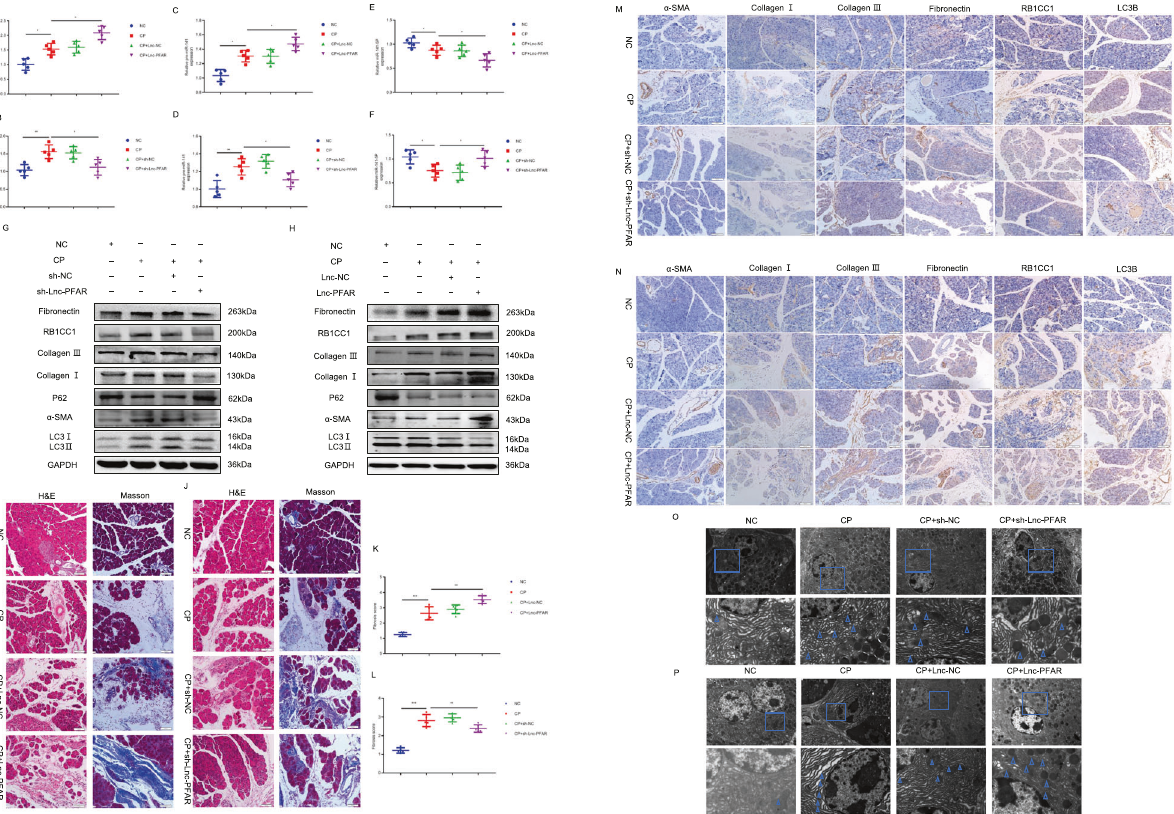
Fig. 5 Lnc-PFAR enhanced pancreatic fi brosis in vivo. A – F The expression levels of Lnc-PFAR, pre-miR-141, and miR-141-5P were explored in pancreatic tissues of negative control, CP, CP plus sh-Lnc-PFAR injection and CP plus Lnc-PFAR injection groups. G – H The expressions of α - SMA, Collagen I, Collagen III, Fibronectin, RB1CC1, P62, and LC3II/I were tested in the negative control, CP, sh-Lnc-PFAR, CP plus sh-Lnc-PFAR, Lnc-PFAR, and CP plus Lnc-PFAR groups. The relative expression represents the ratio of target to GAPDH. I , J The H&E and Masson assays were conducted to indicate CP and pancreatic fi brosis in mouse models ( n = 5) (original magni fi cation, 20×, bars, 50 μ m). K , L The different pancreatic fi brosis scores were compared among negative control, CP, sh-Lnc-PFAR, and CP plus sh-Lnc-PFAR, Lnc-PFAR, and CP plus Lnc-PFAR groups. M , N The expressions of α -SMA, Collagen I, Collagen III, Fibronectin, RB1CC1, P62, and LC3II/I were analyzed by immunohistochemistry (original magni fi cation, 20×, bars, 50 μ m) in different groups. O – P The TEM assays revealed the autophagic levels in different groups (bars, 2 μ